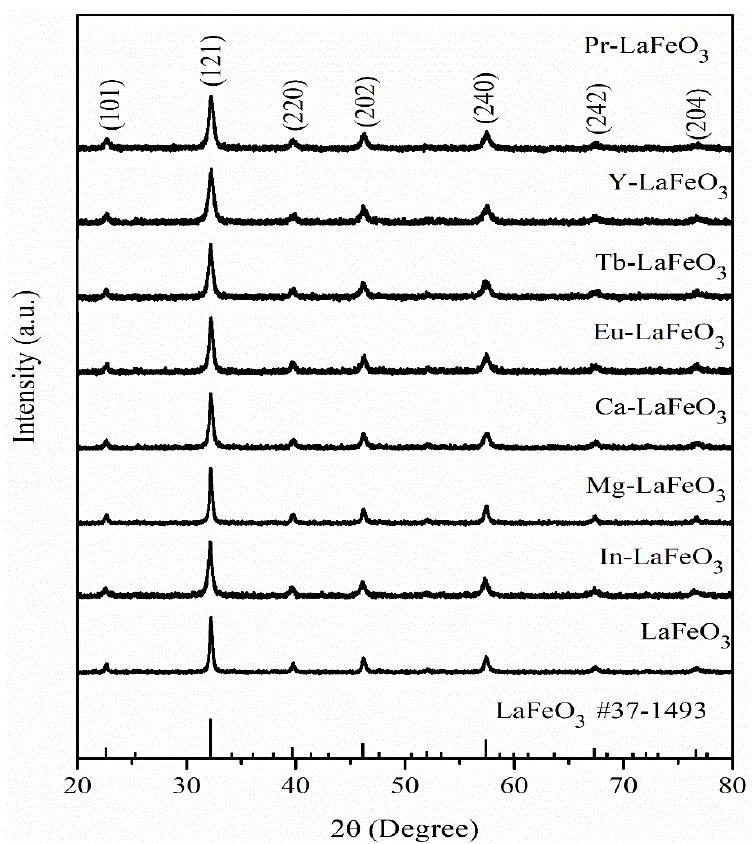
Figure 3. XRD patterns of different metal doped LaFeO 3 photocatalysts.